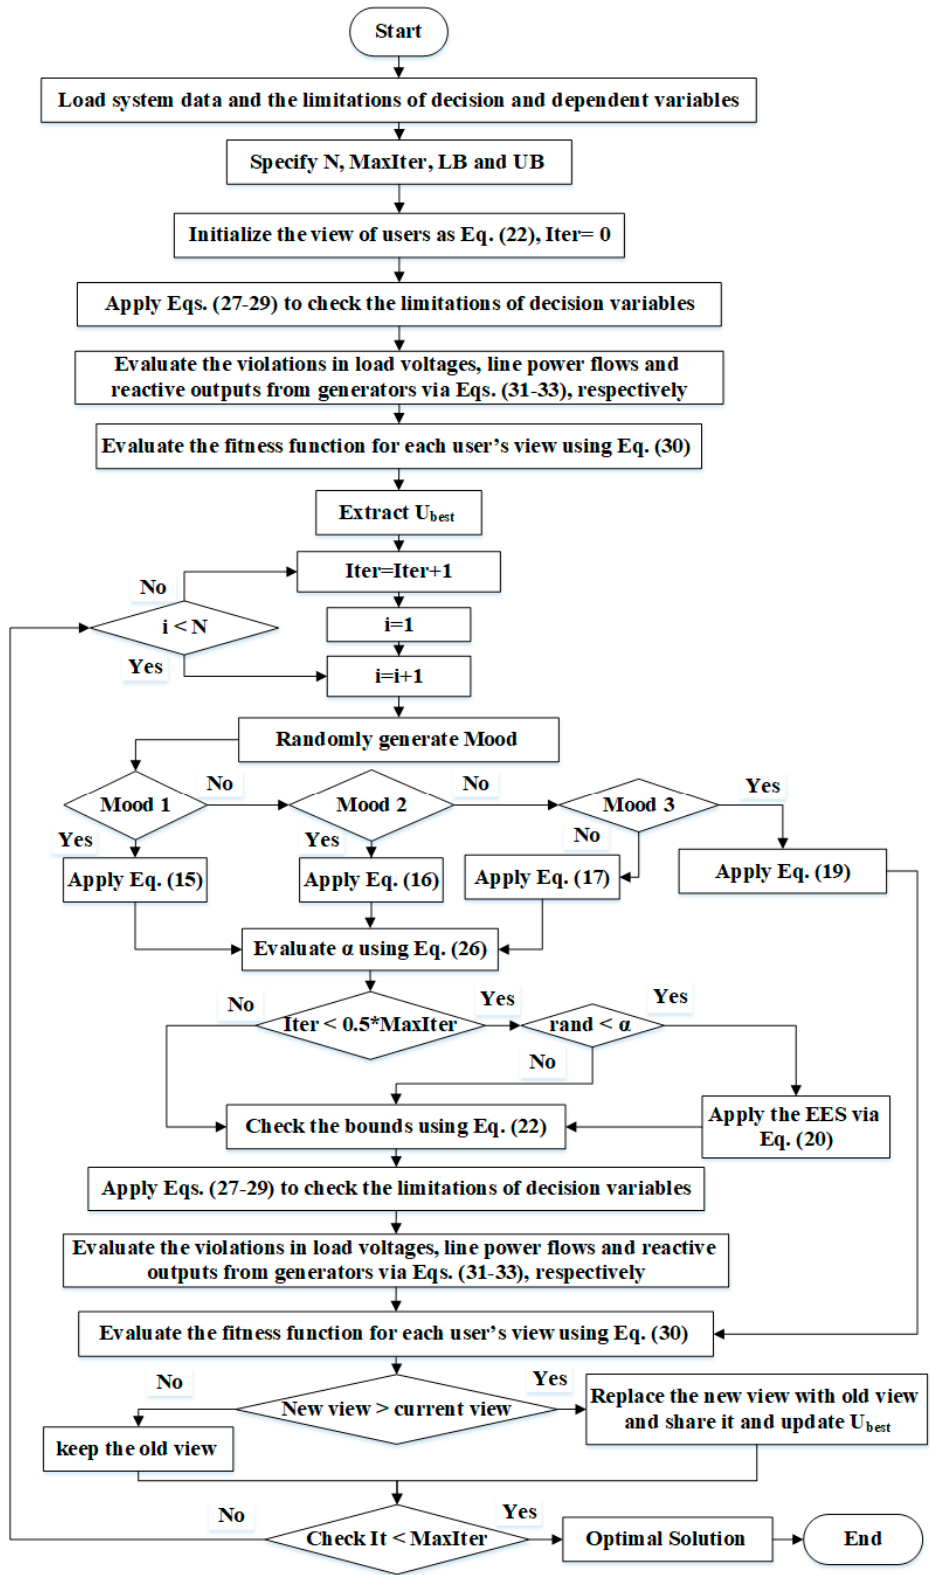
Figure 1. Proposed ASNS for solving the ORPD problem.